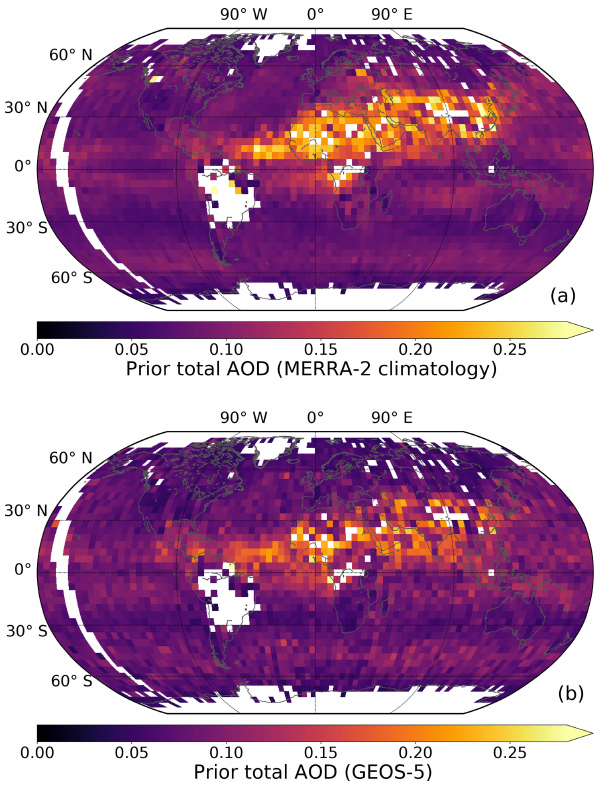
Figure 9. (a) The 4 ◦ × 4 ◦ binned prior AOD for V8, derived from a MERRA-2 monthly climatology. (b) The 4 ◦ × 4 ◦ binned prior AOD for V8 + GEOS-5 types and AODs with low uncertainty, derived from co-located GEOS-5 AODs. White bins represent no